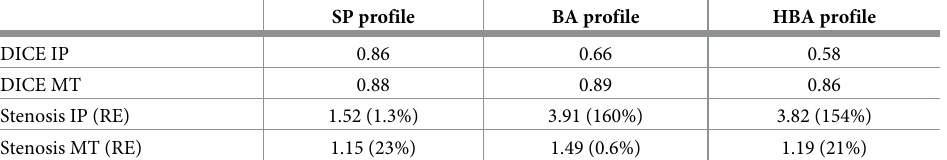
Table 4. DICE quantification and related stenosis lengths in mm for 3D and 4D reconstruction methods for motion profiles SP, BA, and HBA,